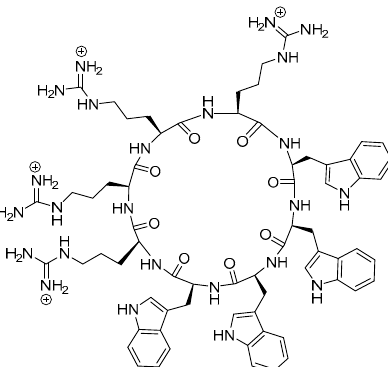
Figure 1. Chemical structures of amphiphilic cyclic peptide [R 4 W 4 ].